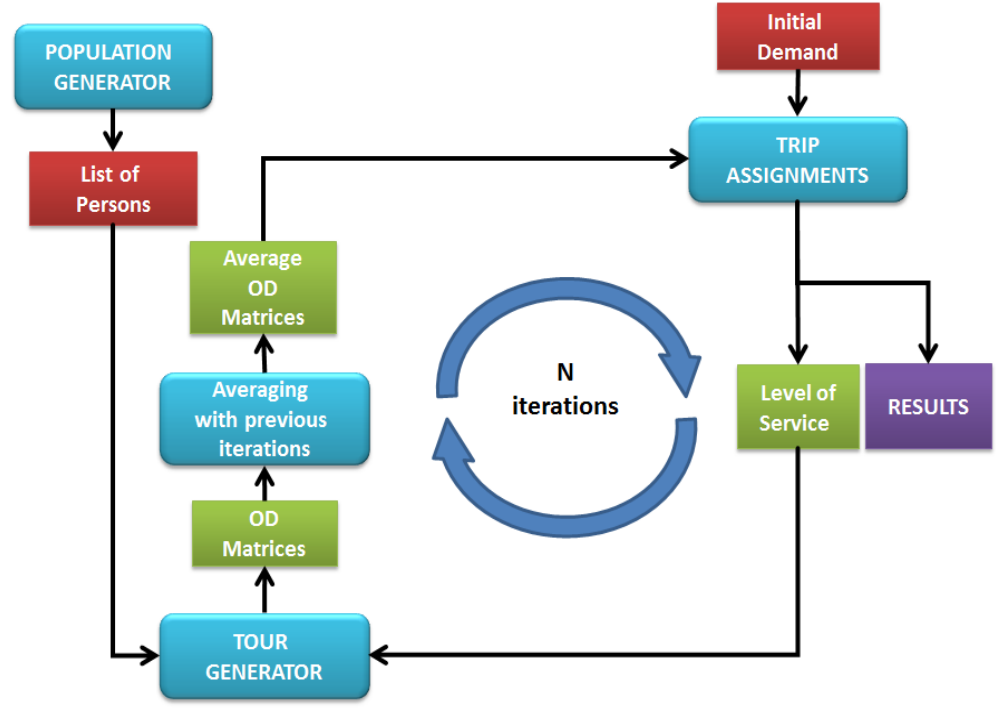
Figure 10. MSA-M